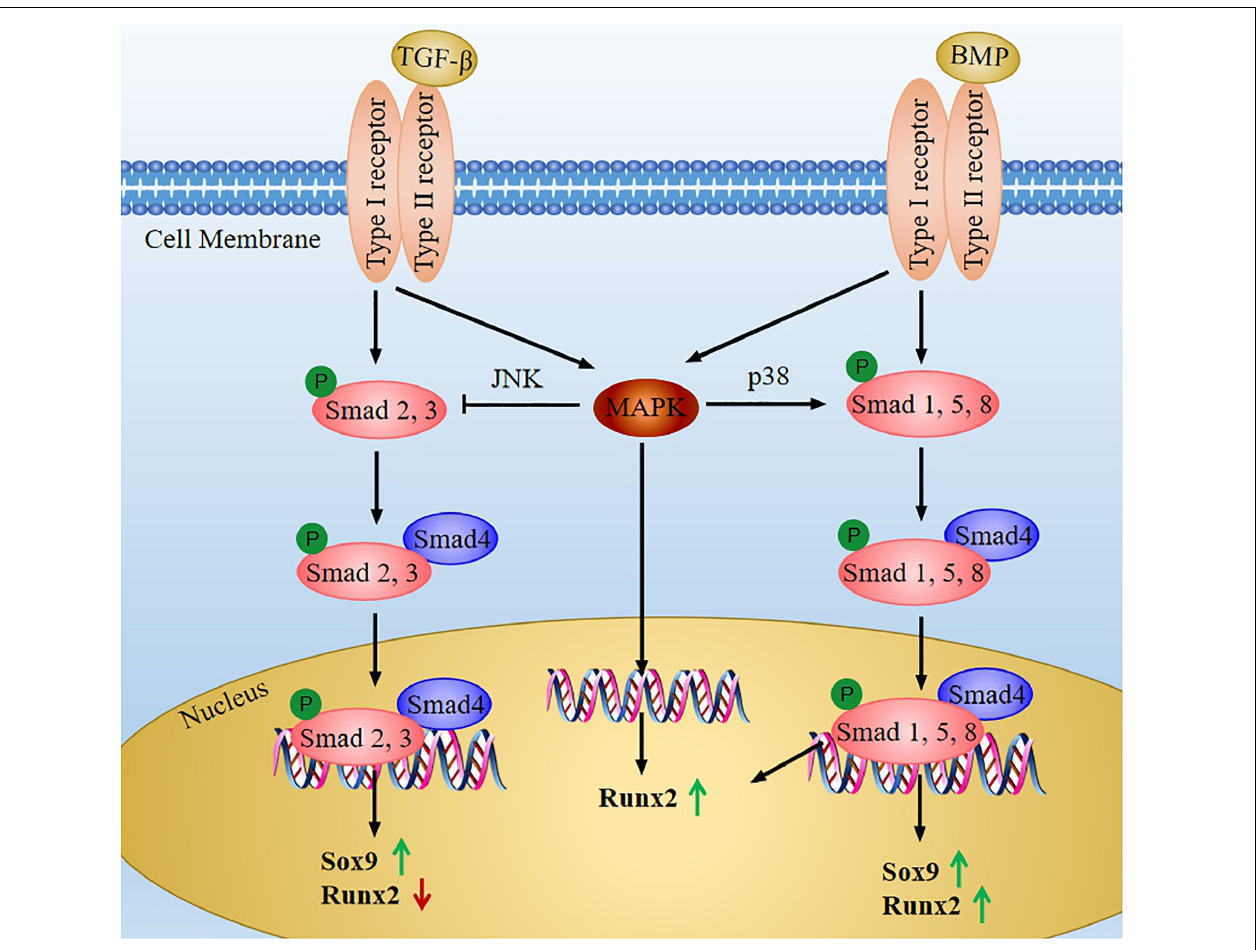
FIGURE 5 | The TGF- β and BMP signaling pathway in chondrocytes. When TGF- β or BMPs bind to type II receptor, type I receptor is transphosphorylated, which activate Smad-dependent signaling or non-Smad-dependent signaling (MAPK signaling). In the Smad-dependent signaling, R-Smads (the TGF- β -specific R-Smads is Smad2, 3 and the BMP-specific R-Smads is Smad1, 5, 8) are phosphorylated, and then it forms complexes with Co-Smad (Smad4). Next the complexes transfer into nucleus to regulate the expression of Sox9 and Runx2. MAPK signaling can phosphorylate Runx2 to increase its transcription activity, and it also can activate JNK and p38 kinases to change the balance between Smad2/3 and